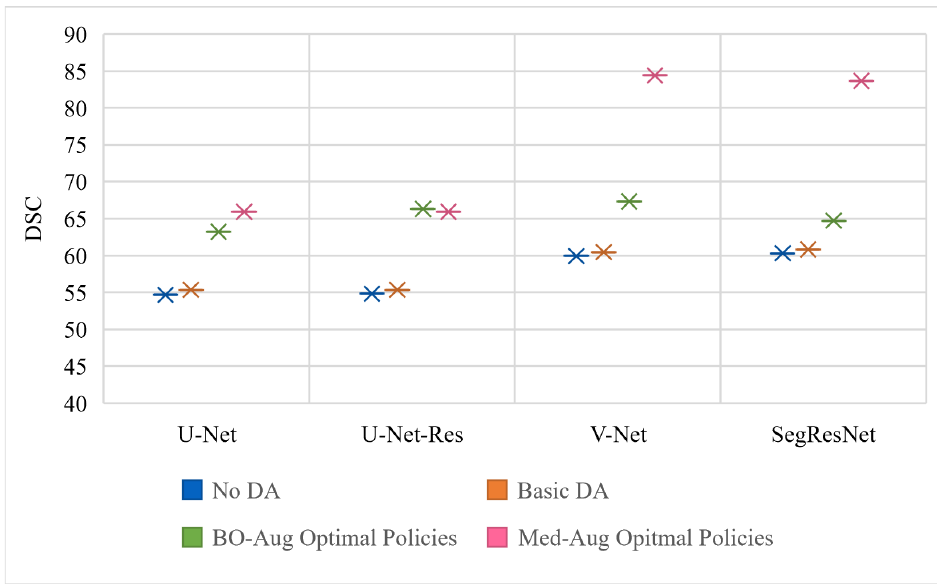
Figure 3. Visualization of the testing performance in DSC of four different neural networks using different DA policies on the training set for the BraTS data experiments.